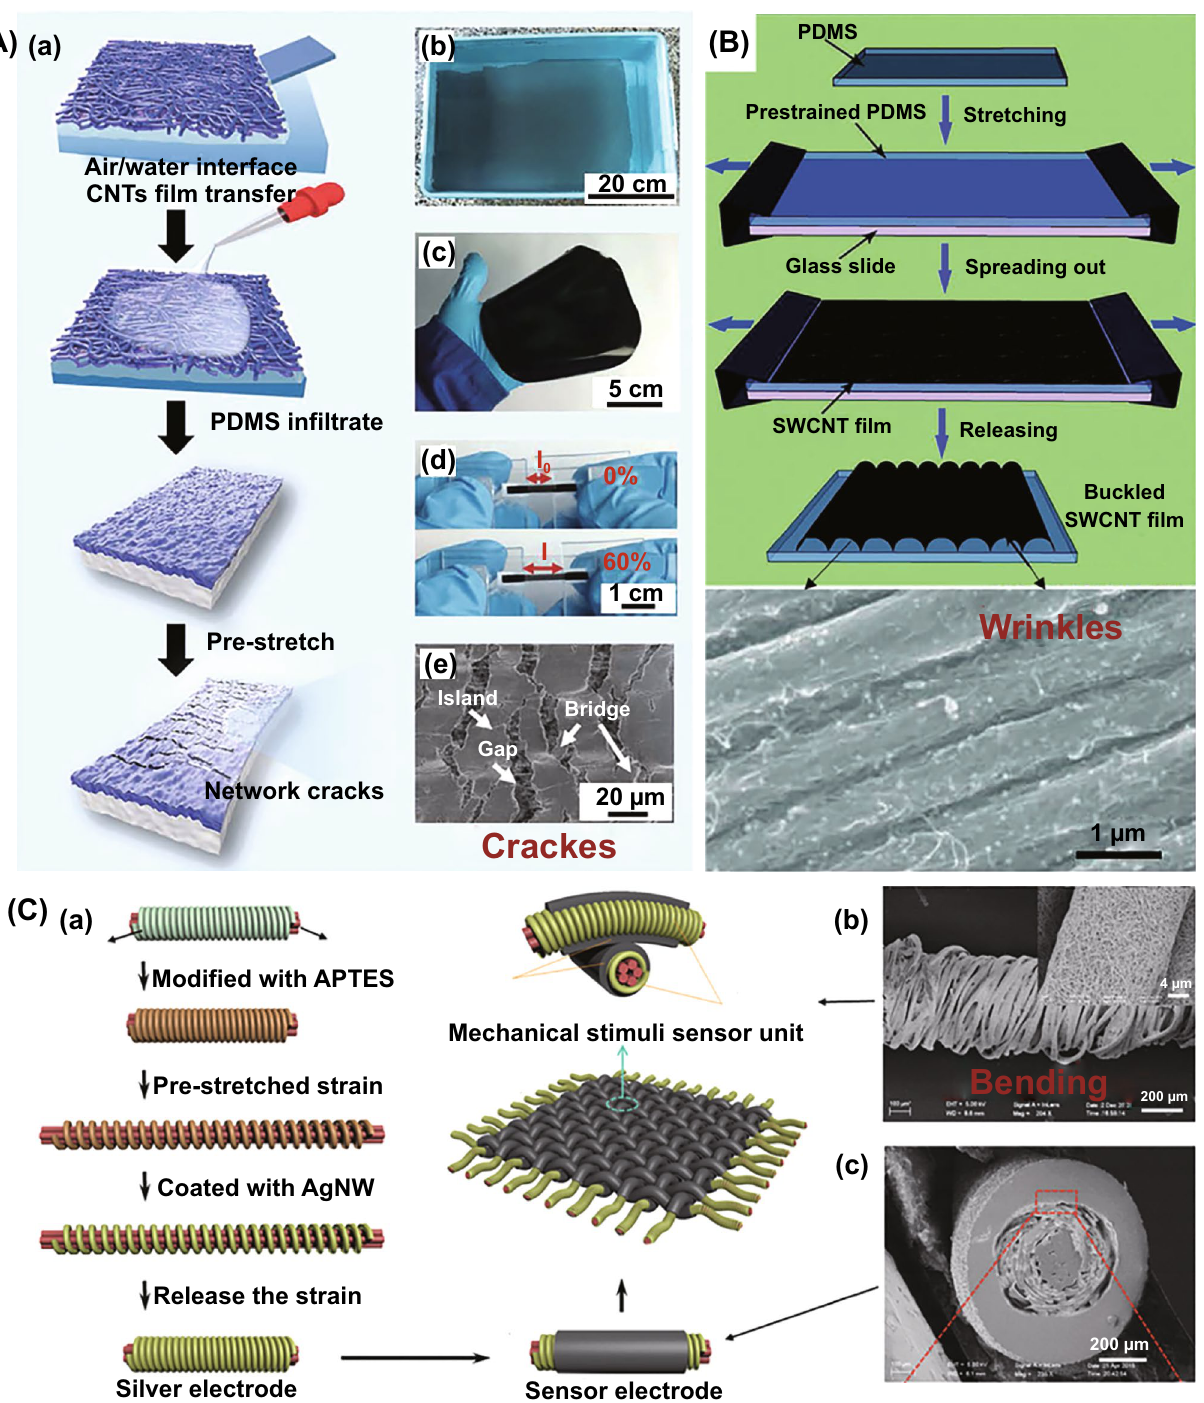
Fig. 4 A Illustration of the fabrication process of CNTs films/polydimethylsiloxane (PDMS) strain sensors and network cracks after pre-stretch- ing, consisting of gaps, islands, and bridges connecting separated islands. Reprinted with permission from Ref. [97]. B Schematic of preparing buckled SWCNT film on PDMS and buckled structure after pre-stretching. Reprinted with permission from Ref. [98]. C Schematic illustration of the fabrication processes of the wound around polyurethane fibers core surfaces coating by AgNW with bending structure of the sensor elec- trode. Reprinted with permission from Ref.